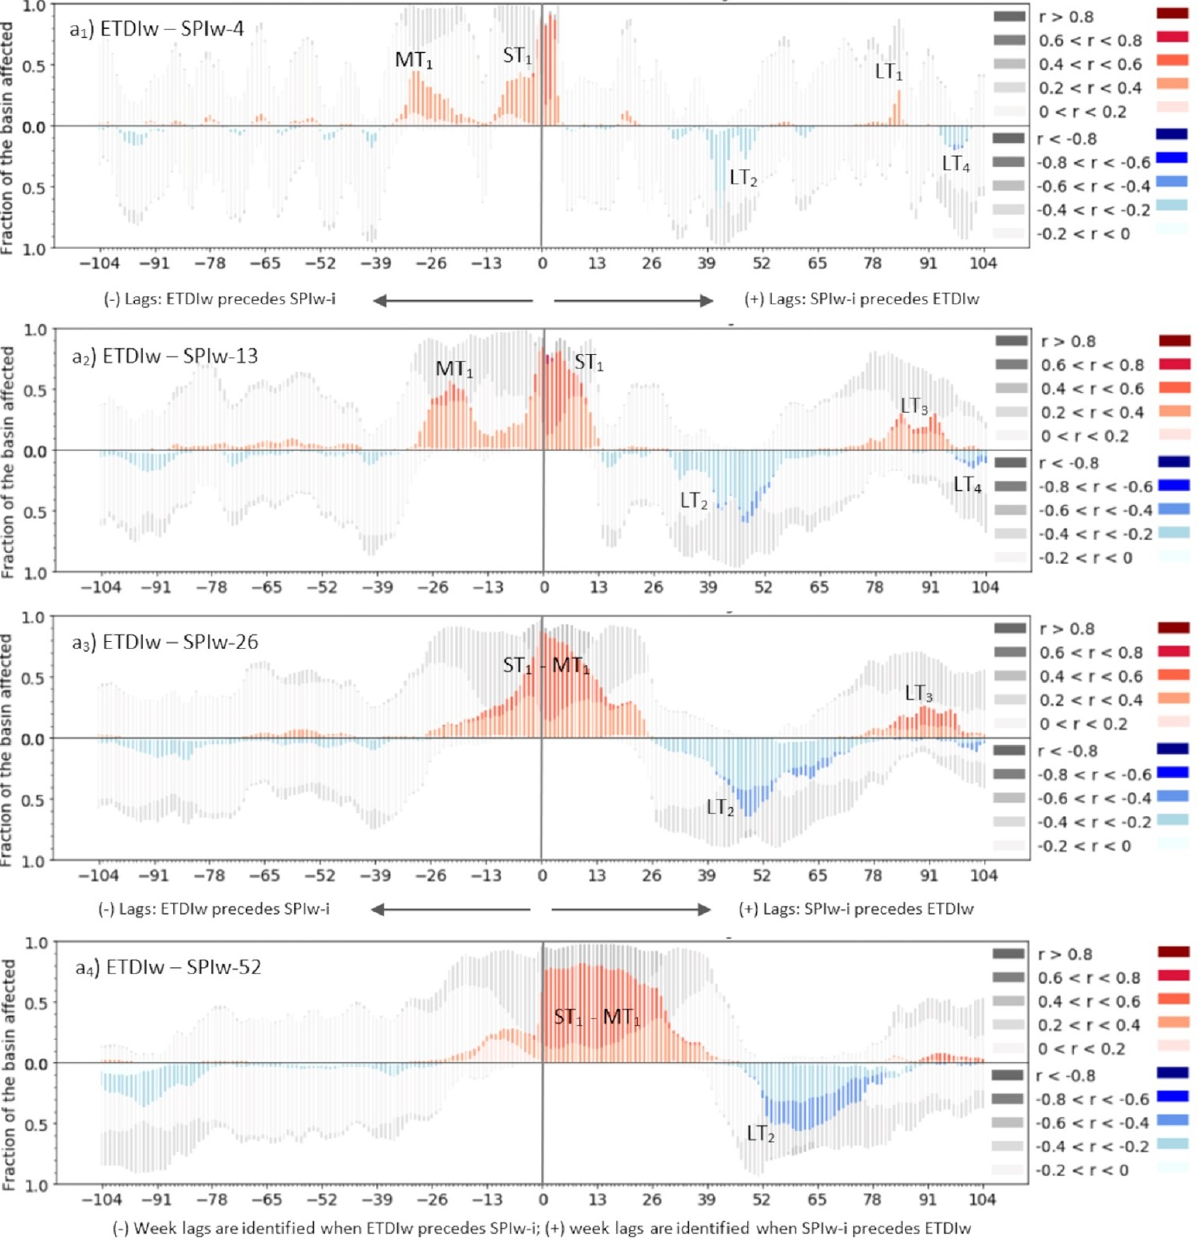
Figure 3. Lag plots of SPI-1, SPI-3, SPI-6 and SPI-12 (expressed as SPIw-4, SPIw-13, SPIw-26 and SPIw-52, respectively) with remote sensing (RS) ETDIw at the weekly scale for the period 2010–2017. Lags are calculated for the − 104 leading and + 104 lagged time steps of ETDIw in reference to SPIw- i . The height of the bars of the plot indicates the area of the basin affected by non-significant (grey scale) or significant (colored scale) correlations. The saturation of the colored scale indicates the magnitude of the significant positive (red) or negative (blue) Pearson correlation coefficient of SPIw- i and